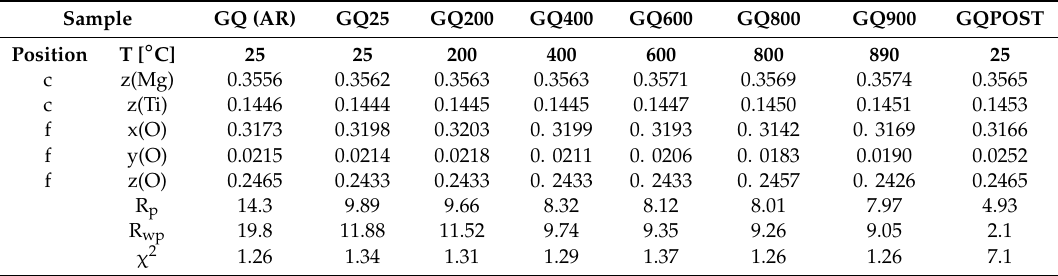
Table 7. Atomic positions for MgTiO 3 in sample GQ as function of temperature (hot-stage).